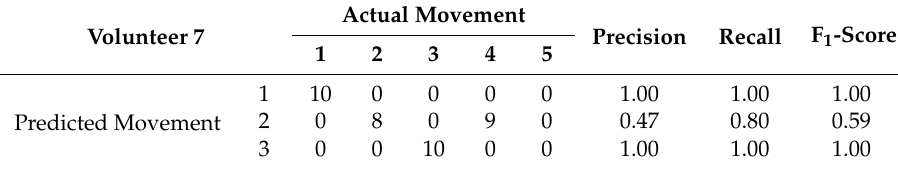
Table A7. Results Volunteer 7.